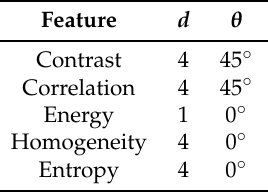
Table 1. Parameters for calculating features.